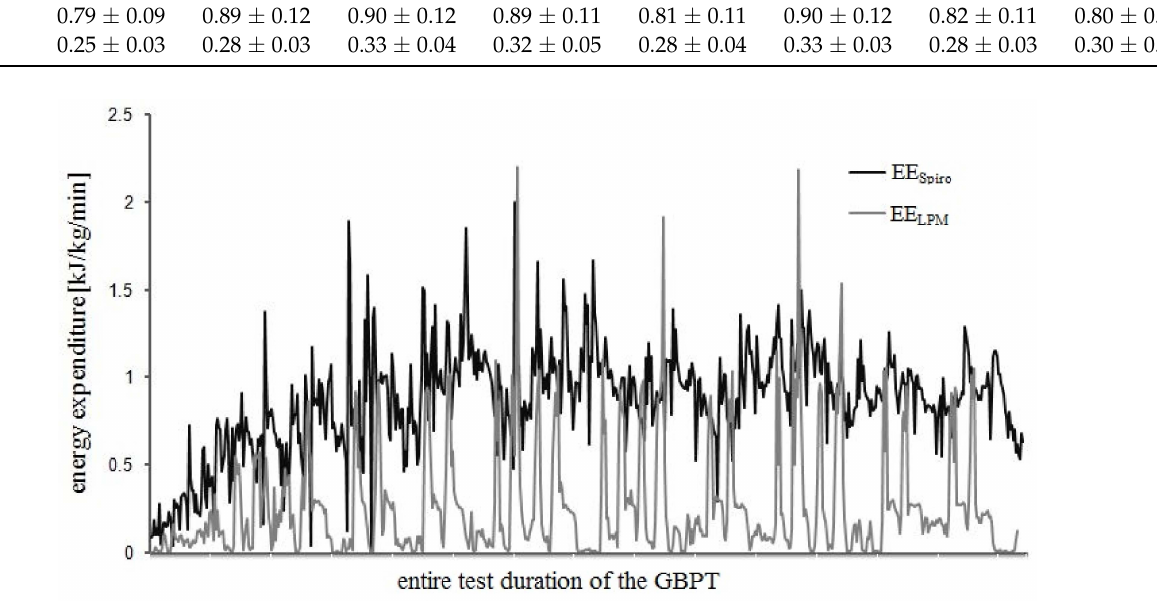
Figure 3. Energy expenditure via spiroergometry (EE Spiro ) and via local position measure- ment (EE LPM ) of the entire game-based performance test (GBPT) of one participant